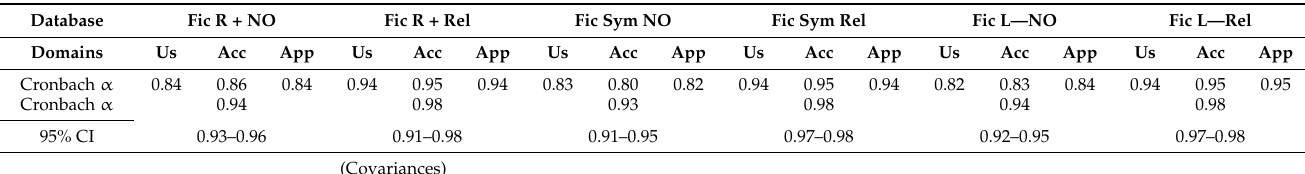
Table 4. Descriptive statistics of polytomous items. Cronbach’s alpha.